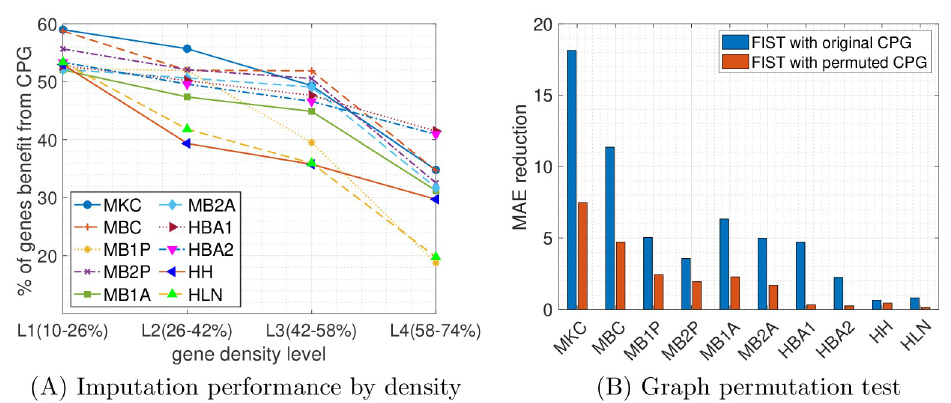
Fig 5. Analysis of Cartesian product graph regularization on gene-wise evaluation. (A) The percentages of genes benefit from the CPG are plotted by their densities in four different ranges. Each colored line represents one of the 10 datasets. (B) The total reduction of MAE using the original and permuted graphs are compared across the 10 tissue sections.